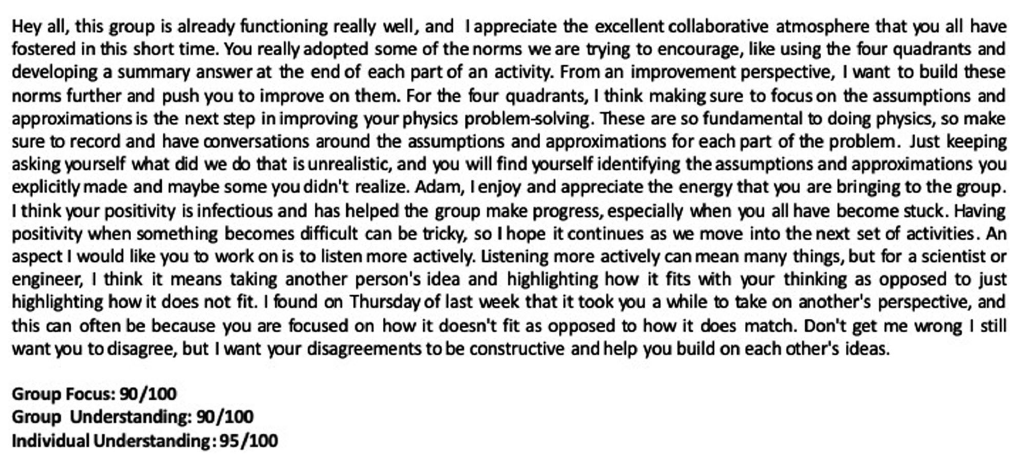
FIG. 2. An example of feedback provided by a P-Cubed tutor to a student, which highlights both the structure of the feedback and the corresponding scores for the